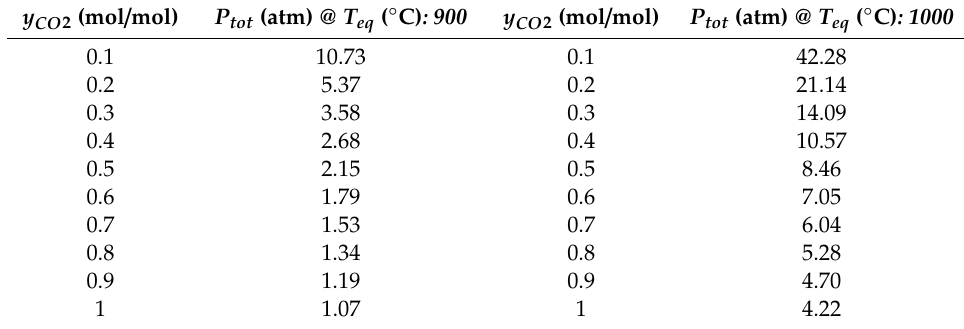
Table 6. Total equilibrium pressure of the CaCO 3– CaO system varying the molar CO 2 fraction for two di ff erent temperature